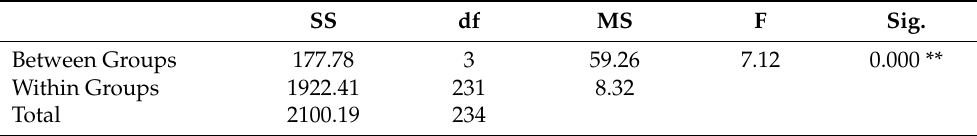
Table 3. Analysis of Variance Family History Knowledge and Marcia’s Identity Stages (1980).